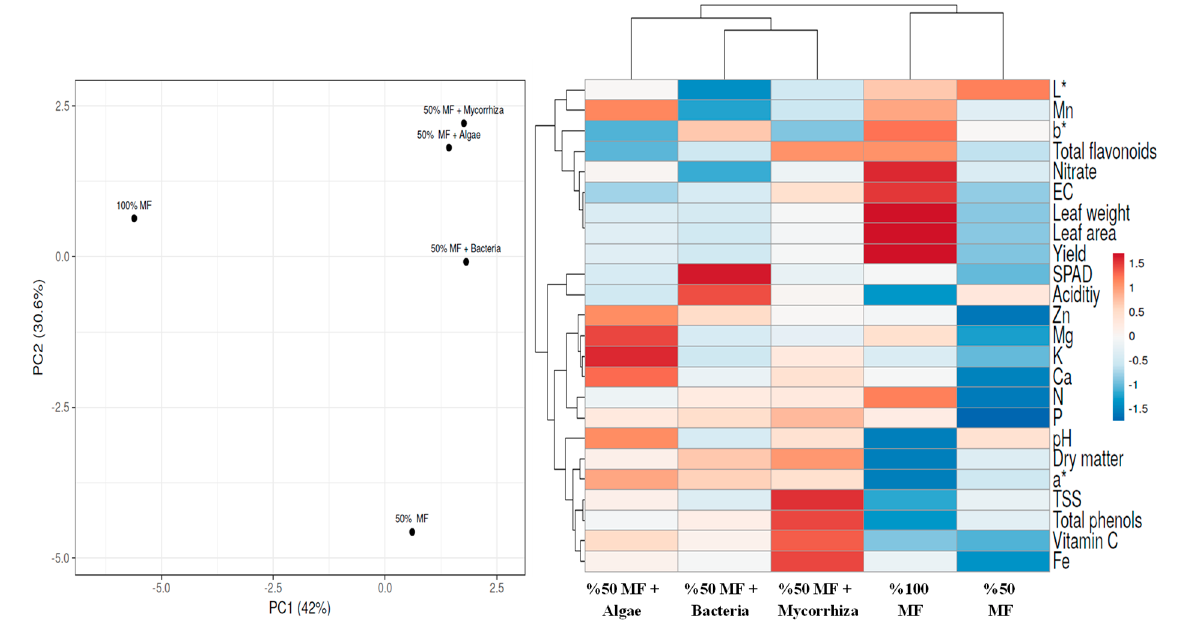
Figure 7. Heat map and principal component analysis of bio-fertilizers related to variables.